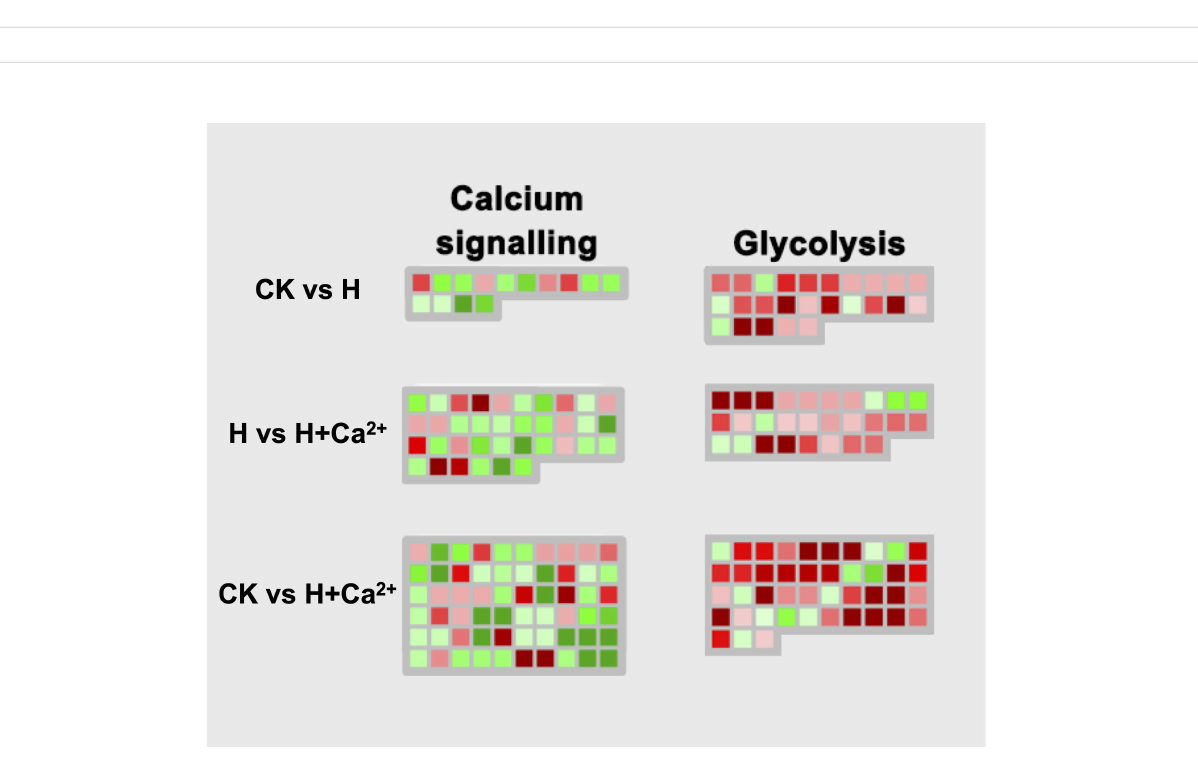
FIGURE 6 Display of gene expression of calcium signaling and glycolysis. Signi fi cantly DEGs (log2 fold changes (FC) ≥ 1, FDR ≤ 0.05) were visualized using Mapman software and organized into functional categories (BINs). Green indicates a decrease and red an increase in gene expression (see color set scale on top right corner). Detailed information on each gene and its expression level is listed in Supplementary Table